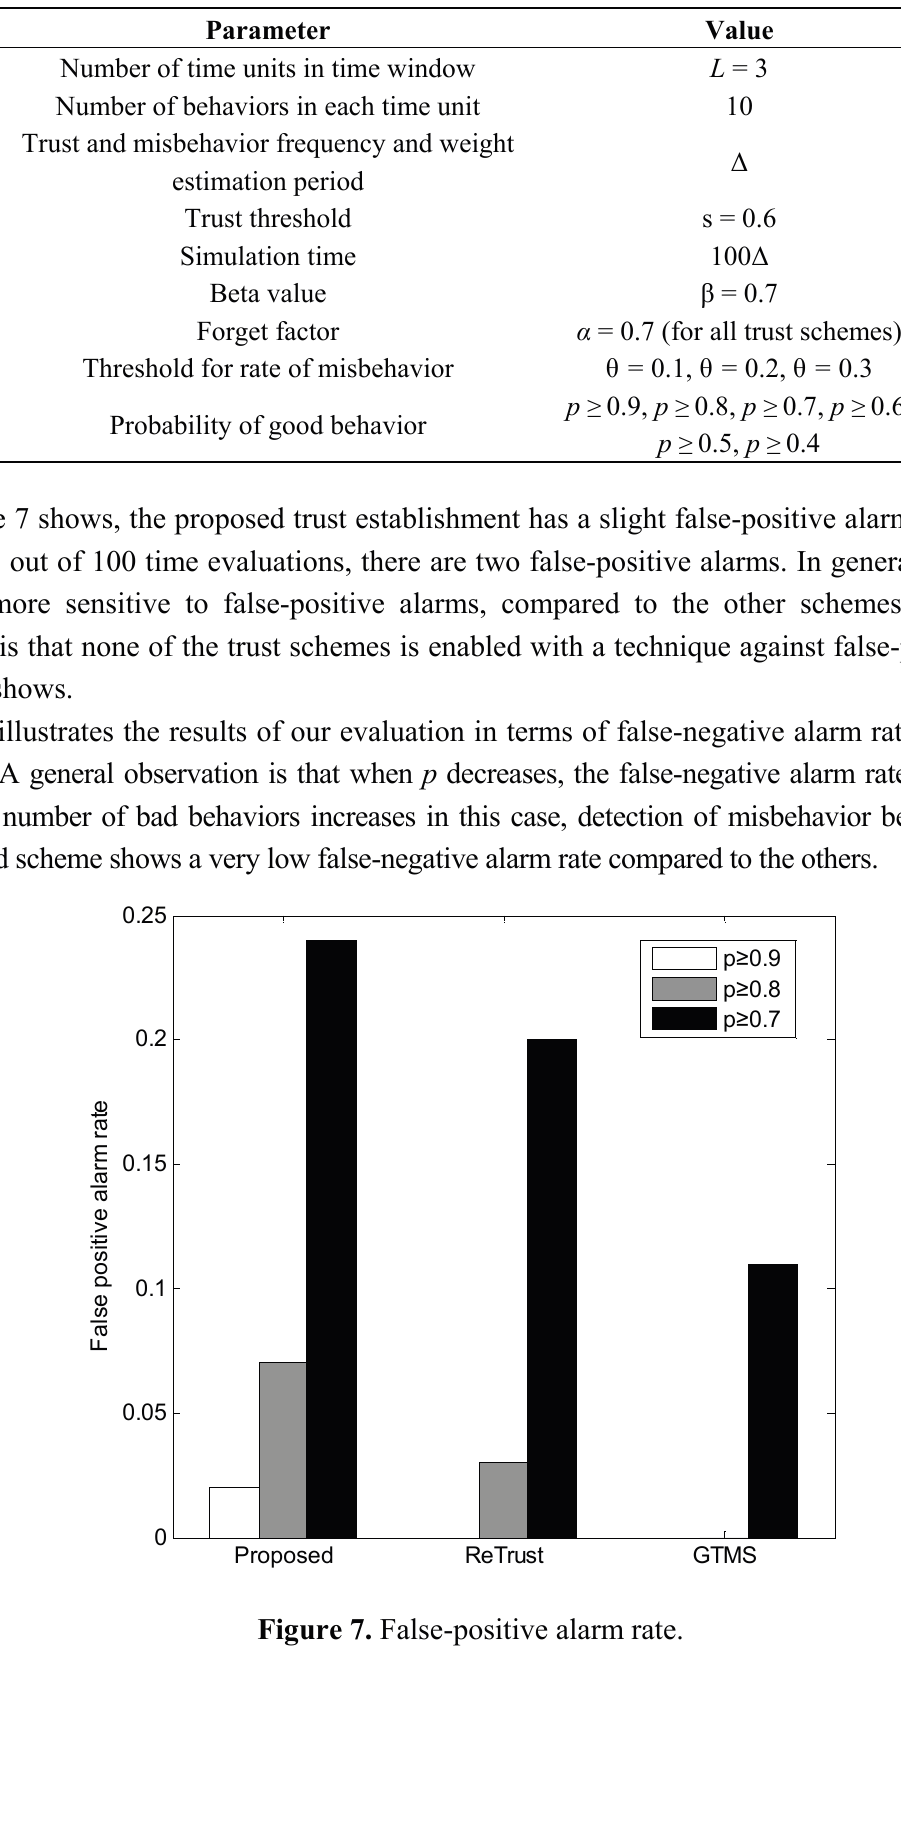
Table 3. False-positive and false-negative alarm rate evaluation parameters.